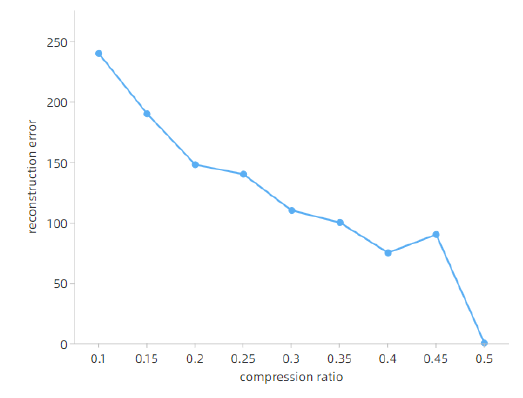
Fig. 3. Reconstruction error of OMP.